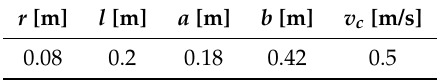
Table 2. Geometric and kinematic